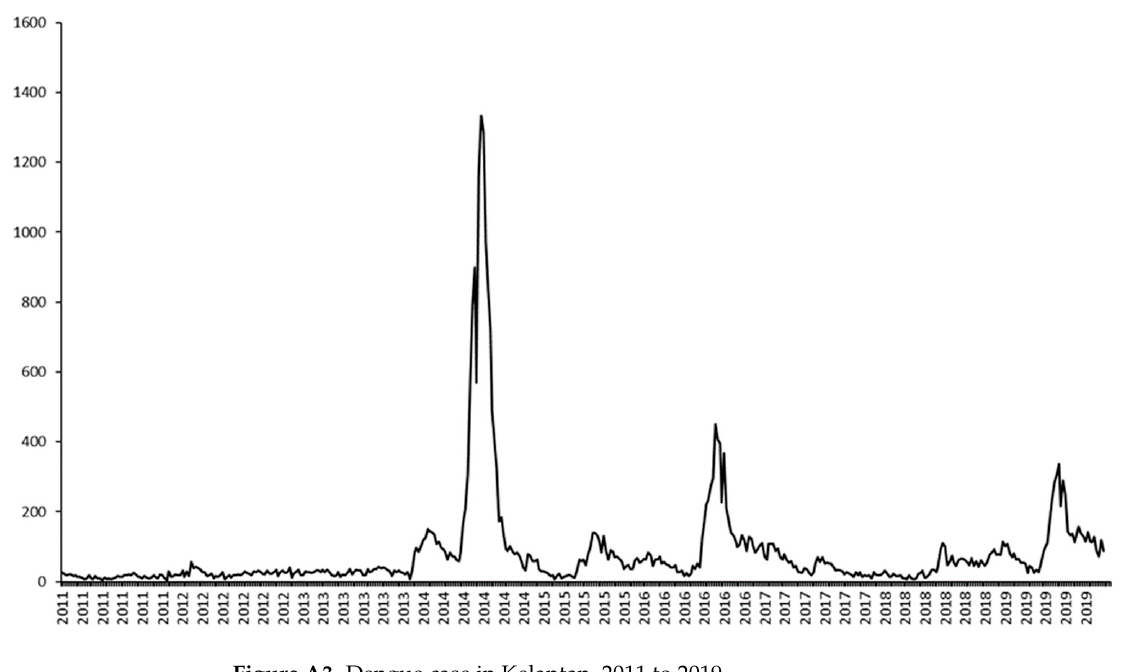
Figure A2. Missing data.